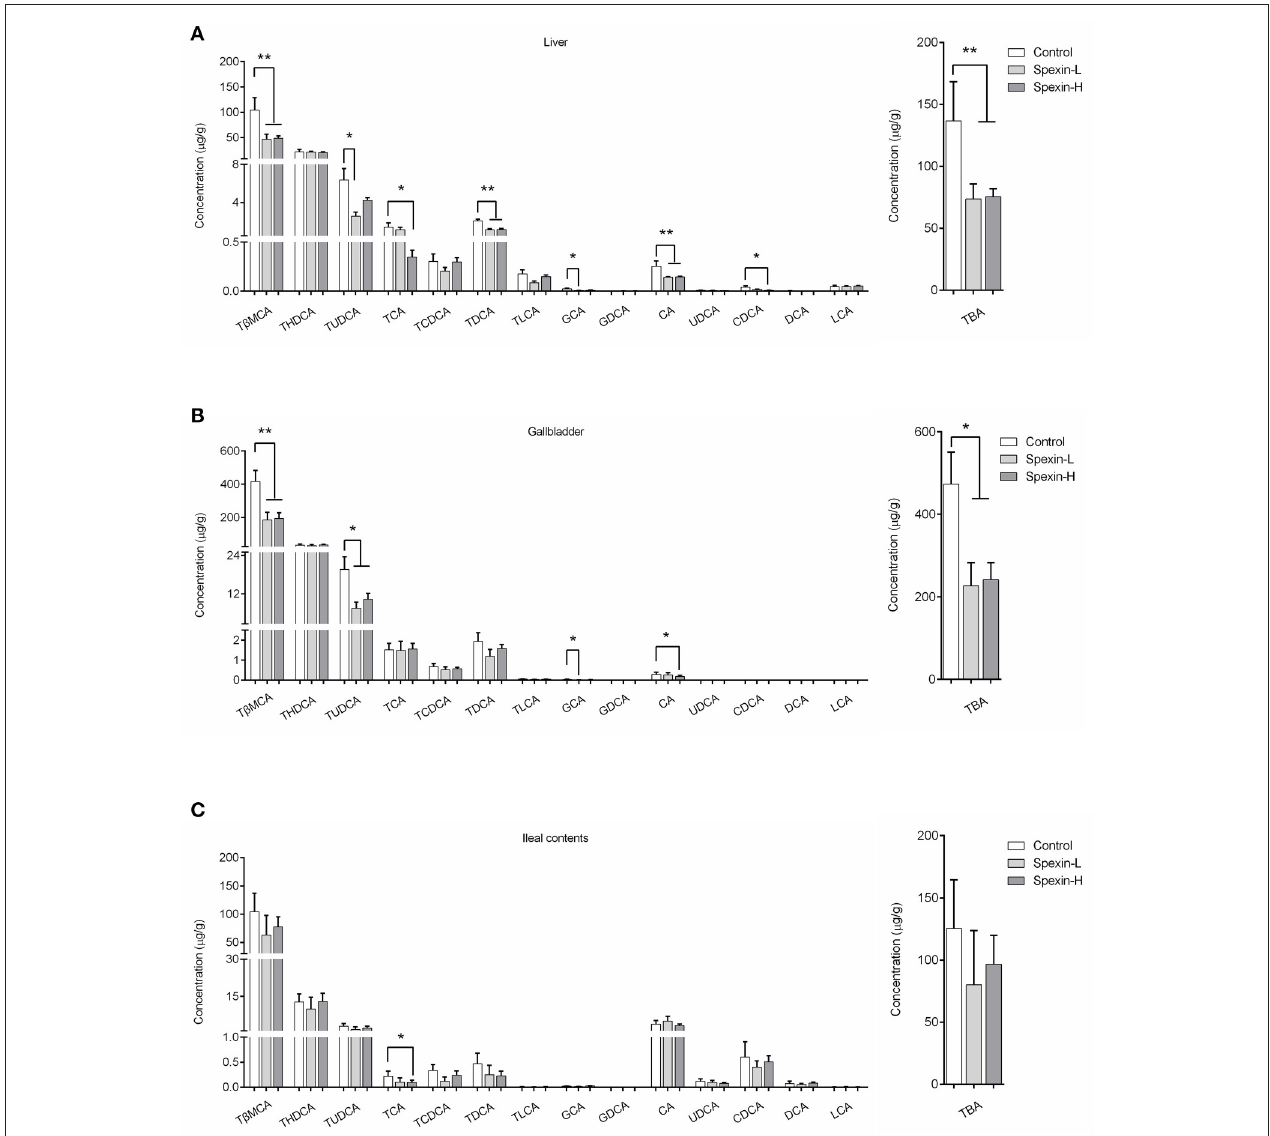
FIGURE 4 | Inhibitory effect of spexin on bile acid metabolites in mice . Specific bile acids were quantified in the liver, gallbladder and ileal contents of male C57BL/6J mice daily i.p. injected with 12.5 µ g/kg spexin (Spexin-L), 25 µ g/kg spexin (Spexin-H) or saline (Control) for 28 consecutive days. Individual bile acid changes were analyzed and TBA concentrations were calculated by sum of all the bile acid measured in the liver (A) , gallbladder (B) , and ileal contents (C) . Results are shown as Mean ± SEM ( n = 10/group). * p < 0.05 and ** p < 0.01 vs. control resulting from Student’s t